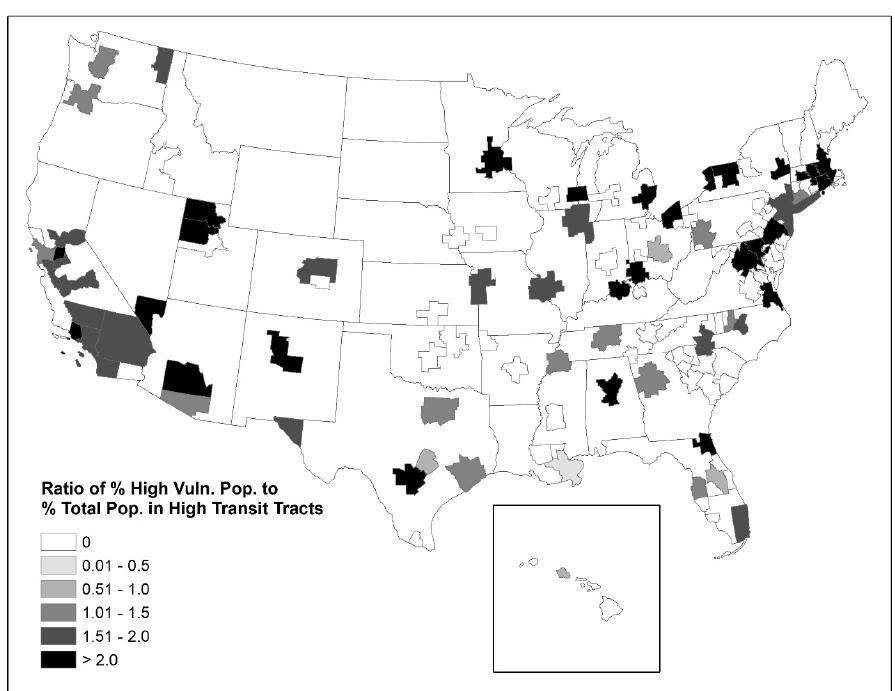
Figure 8. Ratio of the percentage of urban population residing in high (80th percentile)-socially vul- nerable (SV) census tracts also residing within high-transit (transit score ≥ 50 or within 1 km of a rail stop) census tracts to the percentage of all urban population living in high-transit tracts (i.e., “transit equity”) by metropolitan area. Metropolitan areas with equity ratios less than one indicate that urban residents liv- ing in high-SV neighborhoods were, on average, less likely (or equally likely if there were no walkable neighborhoods; the case for Augusta, GA, and Cape Coral, FL, only) than the average urban resident to live in a census tract with high walkability or high-transit ac- cessibility. For walkability this included 32 metros, mostly clustered in the South and Southeast. Many of these metros had few highly walkable or high-transit neighborhoods (e.g., Greensboro, NC, Knoxville, TN, Orlando, FL; Figure 6C), resulting in few resi- dents—either high-SV or low—having access to these amenities. Other metros, including Washington, D.C., New Orleans, LA, Austin, TX, Madison, WI, and Portland, OR (Figure 4D), are particularly notable because they have equity ratios of less than one for walkabil- ity yet contain several highly walkable neighborhoods and have near or above the average proportion (~7%) of all urban residents living in highly walkable census tracts. Thus, we can discern two categories of “low equity” metros in regard to walkability: (1) those with few highly walkable neighborhoods available to low- and high-SV households alike, and (2) those with several highly walkable neighborhoods but SV populations are underrepre- sented and thus may have difficulty affording, or otherwise accessing, these areas. Alt- hough less common, high-transit-accessible neighborhoods appear to be more equitably distributed than highly walkable neighborhoods; only four metros with at least one high- transit-accessible neighborhood had equity ratios less than one: Jacksonville, FL, Ogden, UT, Riverside-San Bernardino, CA, and Sacramento, CA (Figure 6D).